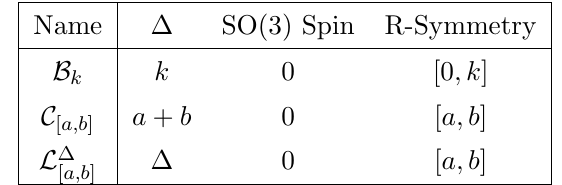
Table 1 . Representations of OSP(4 (cid:3) j 4) that are relevant for the line defect